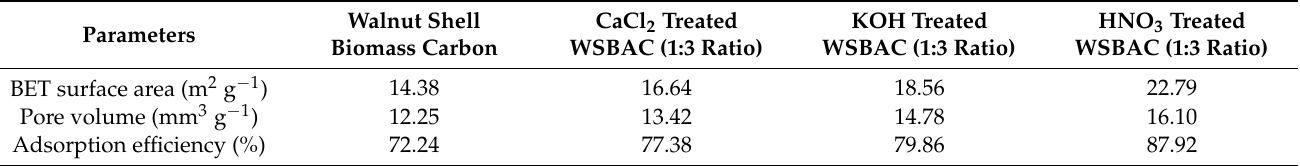
Table 1. Physical properties and adsorption efficiency of walnut shell biomass carbon and WS- BAC